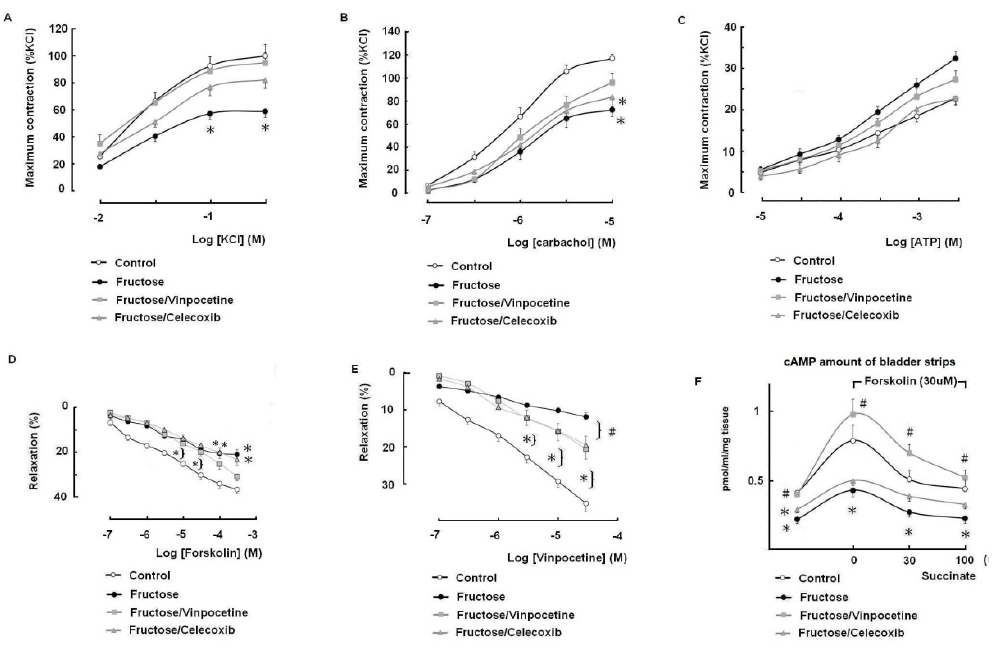
Figure 6. The response curves of the concentrations-related detrusor contractions by using KCl ( A ), carbachol ( B ), and ATP ( C ); the curves of relaxation of the detrusor muscles in response to forskolin ( D ) and vinpocetine ( E ); and the detrusor cAMP levels under forskolin and succinate stimulation ( F ) among the groups. Mucosa-intact bladder strips were used in these studies. Each point represents the mean ± SEM of observations ( n = 8). One-way ANOVA with Bonferroni test: * significant difference compared with the controls ( p < 0.05) and # versus fructose group.